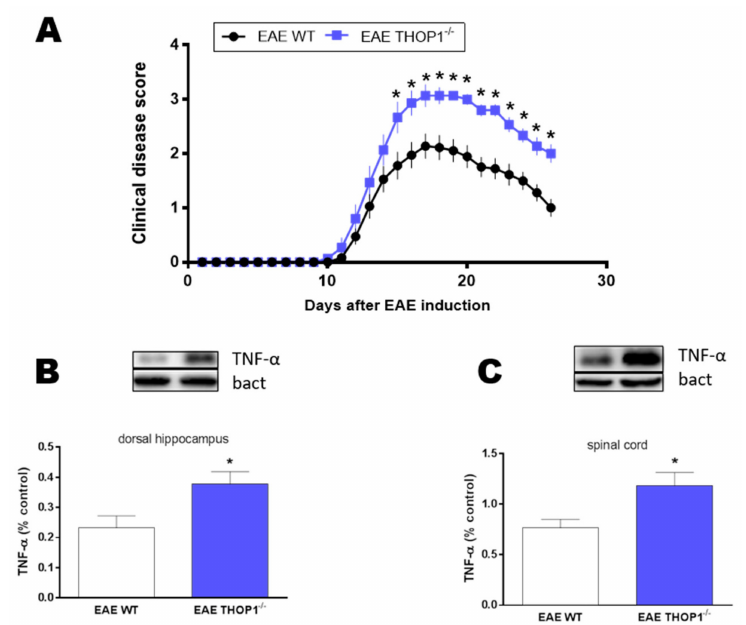
Figure 3. Neurodegeneration induced by EAE and inflammatory profiles. ( A ) Evaluation of the clinical score over time of WT C57BL / 6 female mice and THOP1 - / - immunized with MOG 35-55 emulsified with complete Freund’s adjuvant (CFA). Results are expressed as mean ± S.E.M. Statistical significance